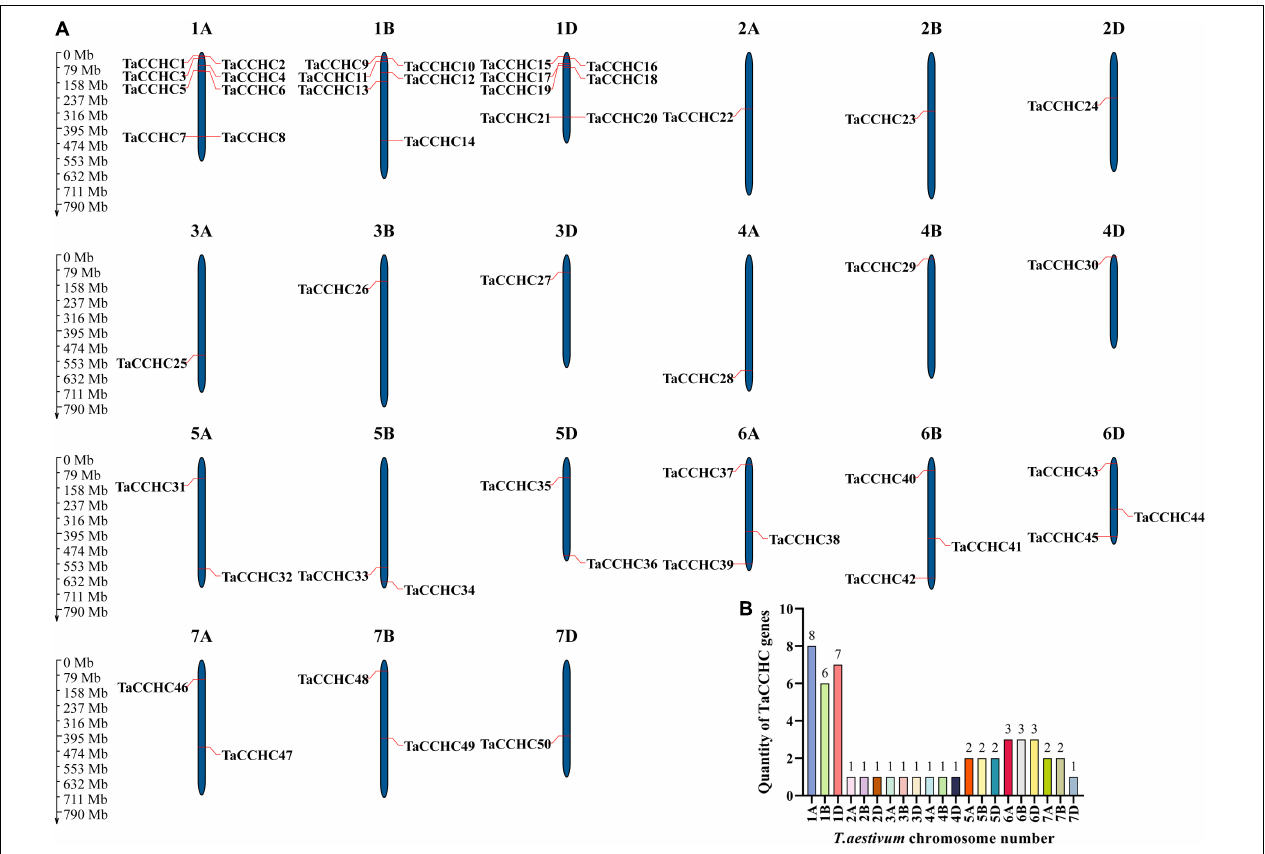
FIGURE 4 | Chromosome distribution of the wheat CCHC-ZFP genes. (A) Chromosomal localization of the TaCCHC-ZFP genes. The dark blue columns indicate wheat chromosomes with the scale in megabases (Mb). The chromosome number is displayed at the top of each chromosome. (B) Numbers of TaCCHC-ZFP genes on each T. aestivum